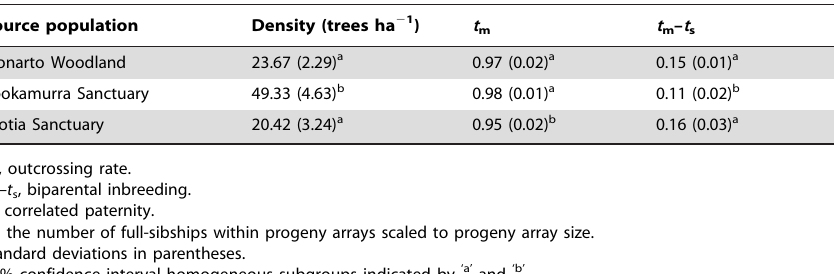
Source population